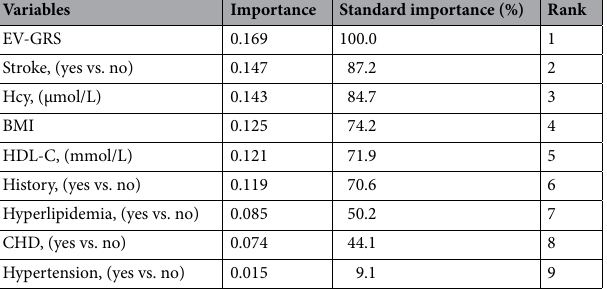
Table 4. The importance of variables in ANN model. EV-GRS explained variance genetic risk score, Hcy homocysteine, HDL-C high density lipoprotein cholesterol, CHD coronary heart